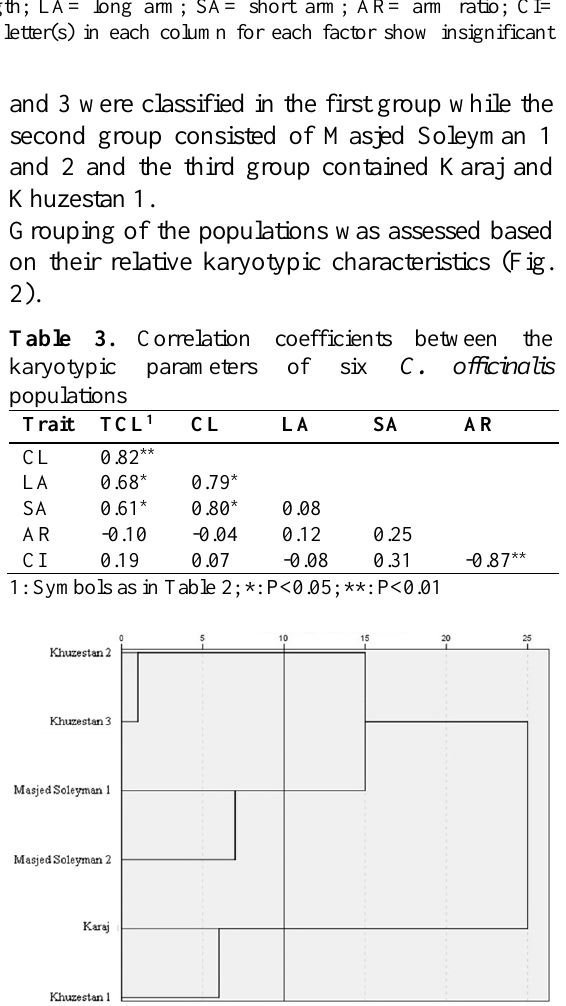
Fig. 2. UPGMA cluster dendrogram based on all studied chromosomal traits of 6 populations of